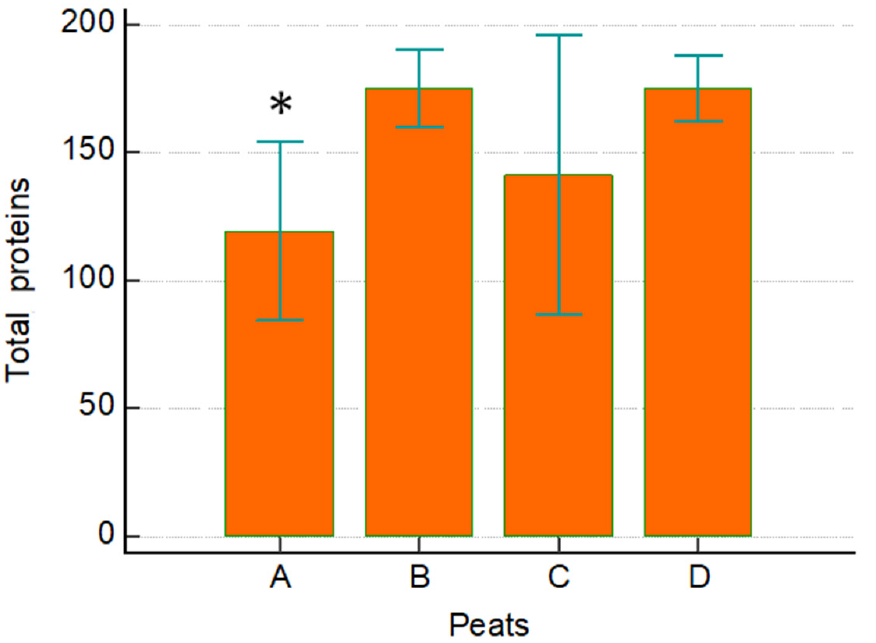
Figure 2. Number of proteins (mg/mL) found in the M-peat samples: basic peat (A), after 6 months (B), after 16 months (C), and after 36 months (D). * p = 0.002 versus B and D. Table 2. Maturation period of peat and total protein, thiol protein, and lipid content.